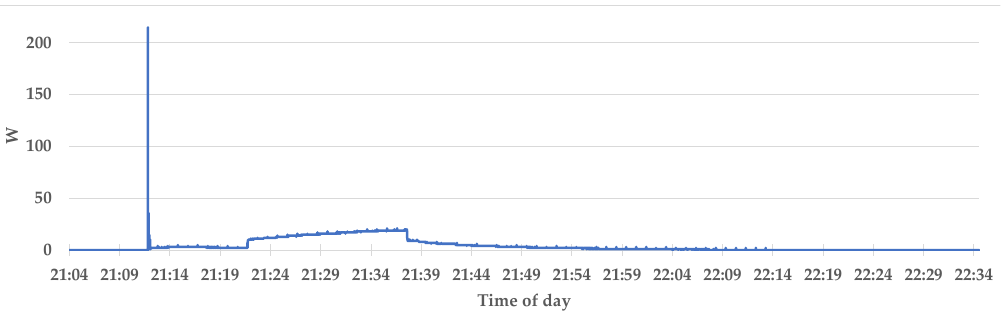
Figure 18. Load profile of the refrigerator.